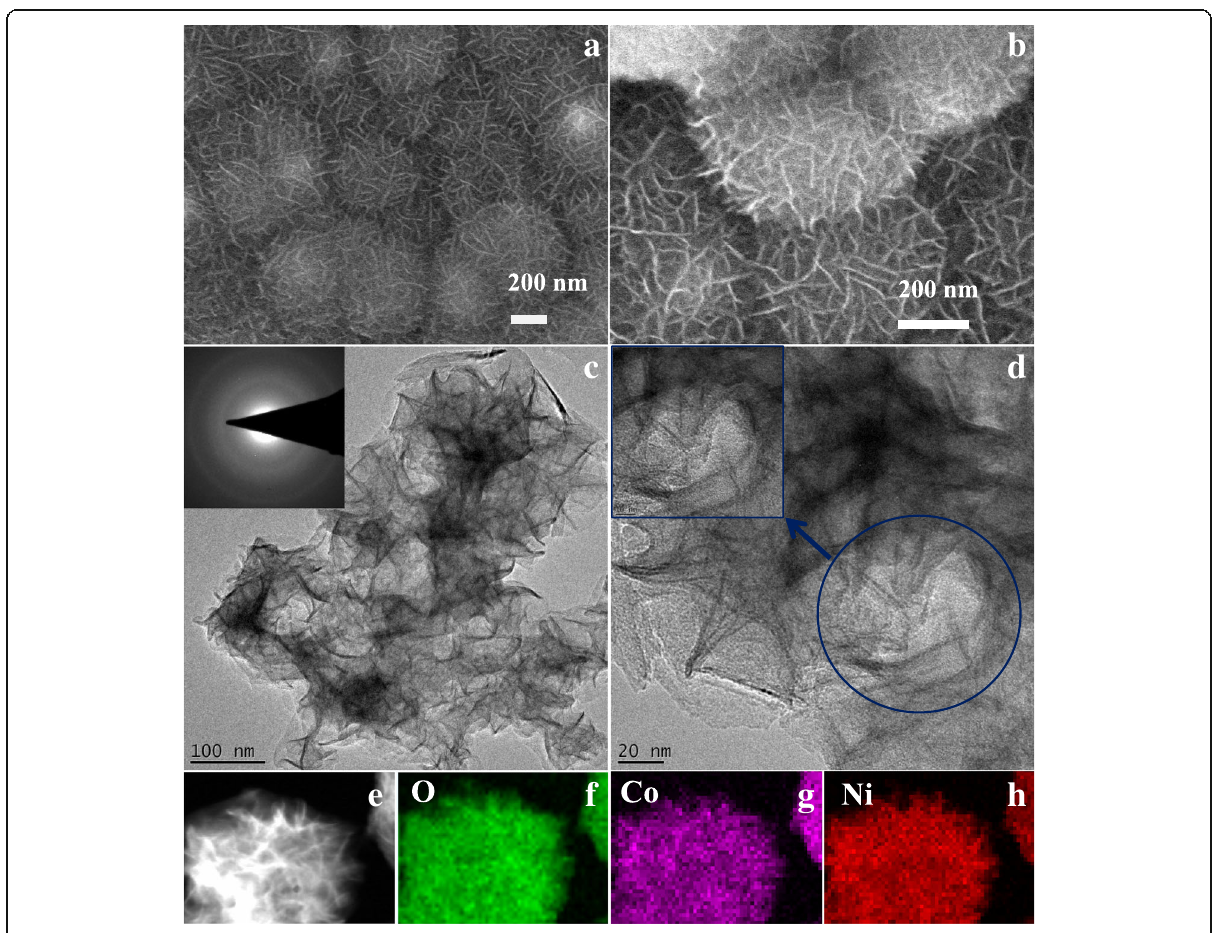
Fig. 1 Morphology and structure of the products. a , b SEM images of the amorphous Co-Ni hydroxide deposited on a graphite sheet. c , d TEM images of the amorphous Co-Ni hydroxide sample (the insets show the corresponding SAED pattern and HRTEM image). e STEM image. f – h Element mappings of O, Co, and